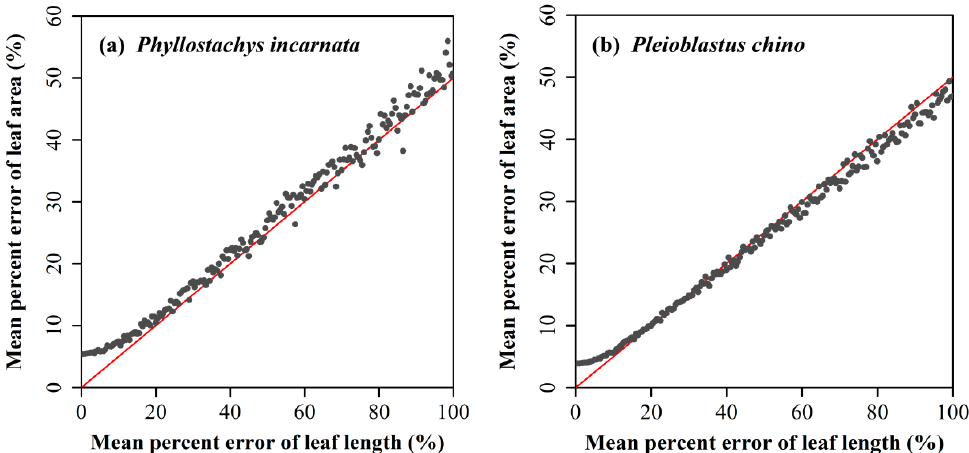
Figure 7. Effect of the mean percent error of leaf length on the mean percent error of leaf area based on the data of ( a ) Phyllostachys incarnata and ( b ) Pleioblastus chino (i.e., datasets 4 and 5). The grey solid circles represent the planar coordinates consisting of the mean percent error of leaf length (MPEL, as x -coordinate) and the mean percent error of leaf area (MPEA, as y -coordinate); the red straight line came from the equation y = 1/2 x . Take a grey solid circle whose MPEL equals 20% in panel ( a ), for example. There are 209 leaves for Ph. incarnata whose observations of leaf length and area are